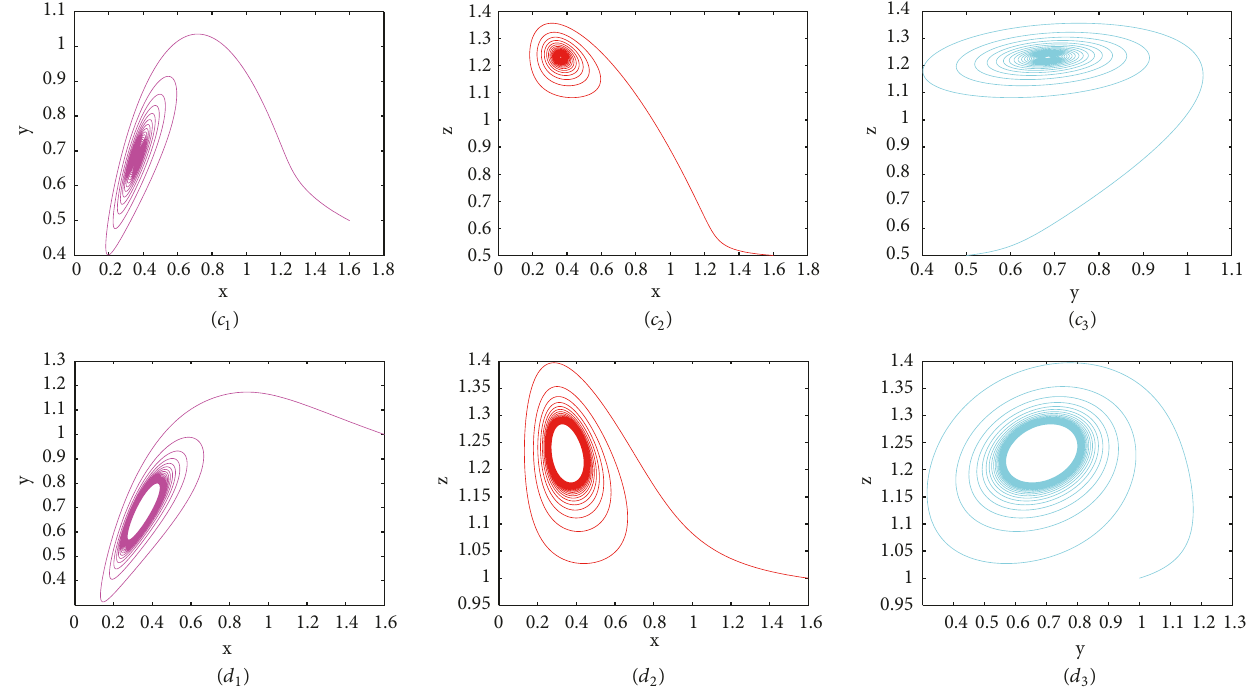
Figure 7: The results of Experiment 4: (𝑐 𝑖 ) with 𝑘 1 = 0.958 and (𝑑 𝑖 ) with 𝑘 1 = 0.989(𝑖 = 1,2, 3) , (𝑐 1 ) and (𝑑 1 ) projected on the (𝑥, 𝑦) -plane; (𝑐 ) and (𝑑 ) projected on the (𝑥, 𝑧) -plane; (𝑐 2 2